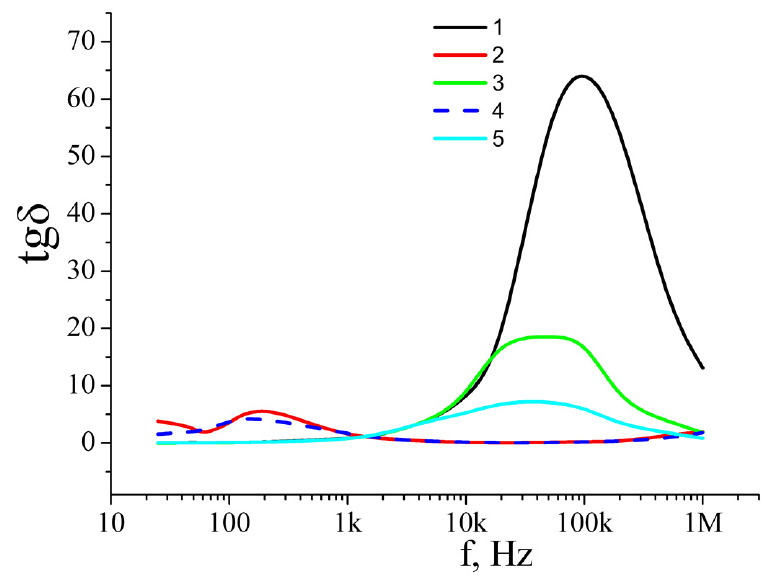
Figure 12. Dependences of dissipation factor of the studied films on frequency: ( 1 ) TiO 2 layer; ( 2 ) two layers: TiO 2 /Ag_NW; ( 3 ) two layers: TiO 2 /Ag_NW_MW; ( 4 ) three layers: TiO 2 /Ag_NW/TiO 2 ; ( 5 ) three layers: TiO 2 /Ag_NW_MW/TiO 2 .